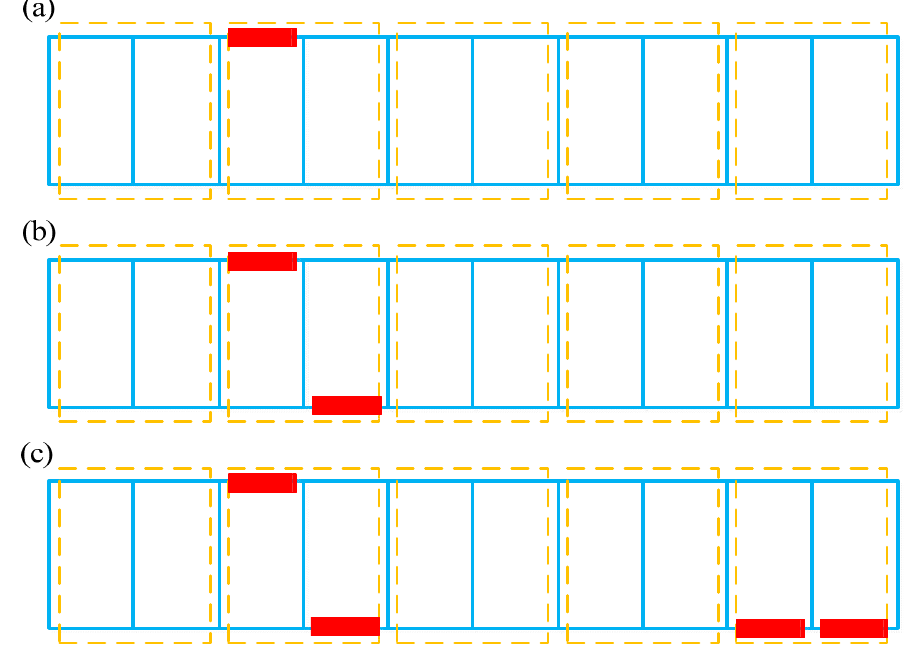
Figure 7. Damage configurations for the truss bridge model: ( a ) Case 1 (E3); ( b ) Case 2 (E3 and E14); ( c ) Case 3 (E3 and E14 and E19 and E20). Table 4. Damage cases considered for the steel truss bridge model.